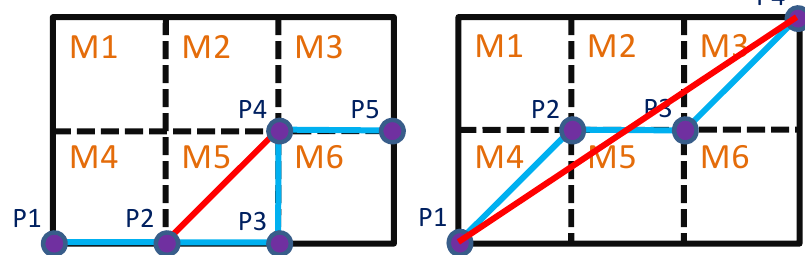
Figure 8. The example diagram of the path smoothing